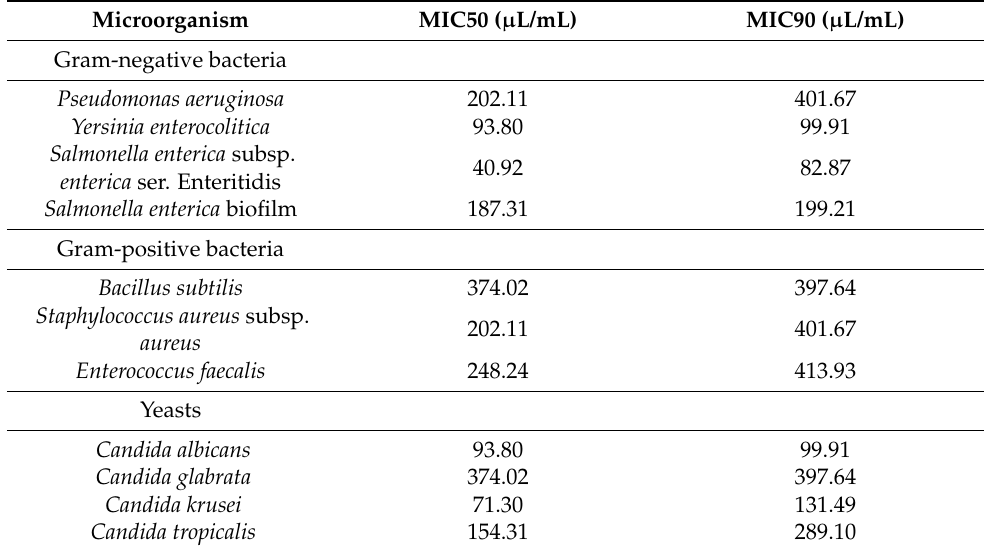
Table 4. Antimicrobial activity of